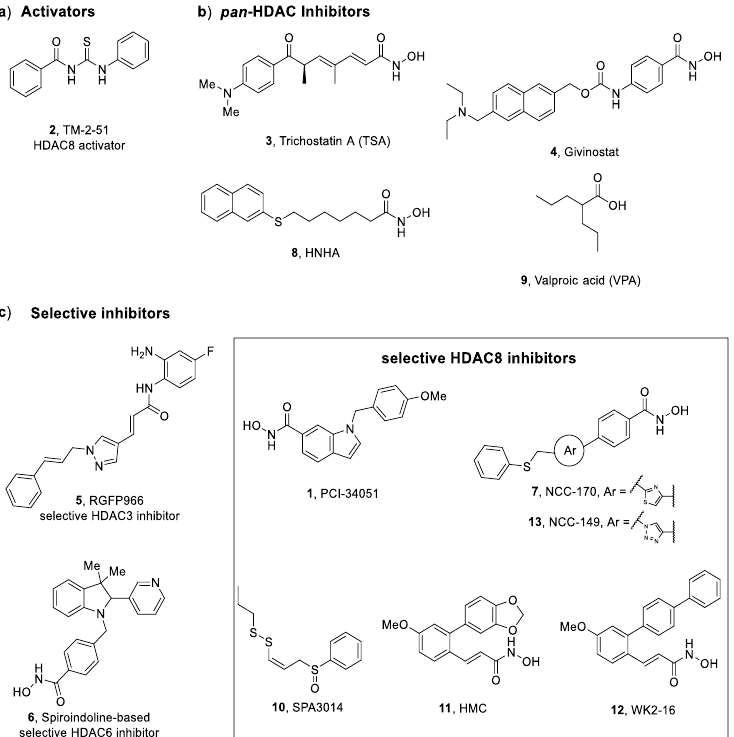
Figure 3. HDAC activators ( 2 ) and inhibitors ( 1, 3 - 13 ) explored in key pathologies: ( a ) thiou- rea-based activator of HDAC8, ( b ) pan -HDAC inhibitors, ( c ) selective HDAC inhibitors. activator of HDAC8, ( b ) pan -HDAC inhibitors, ( c ) selective HDAC